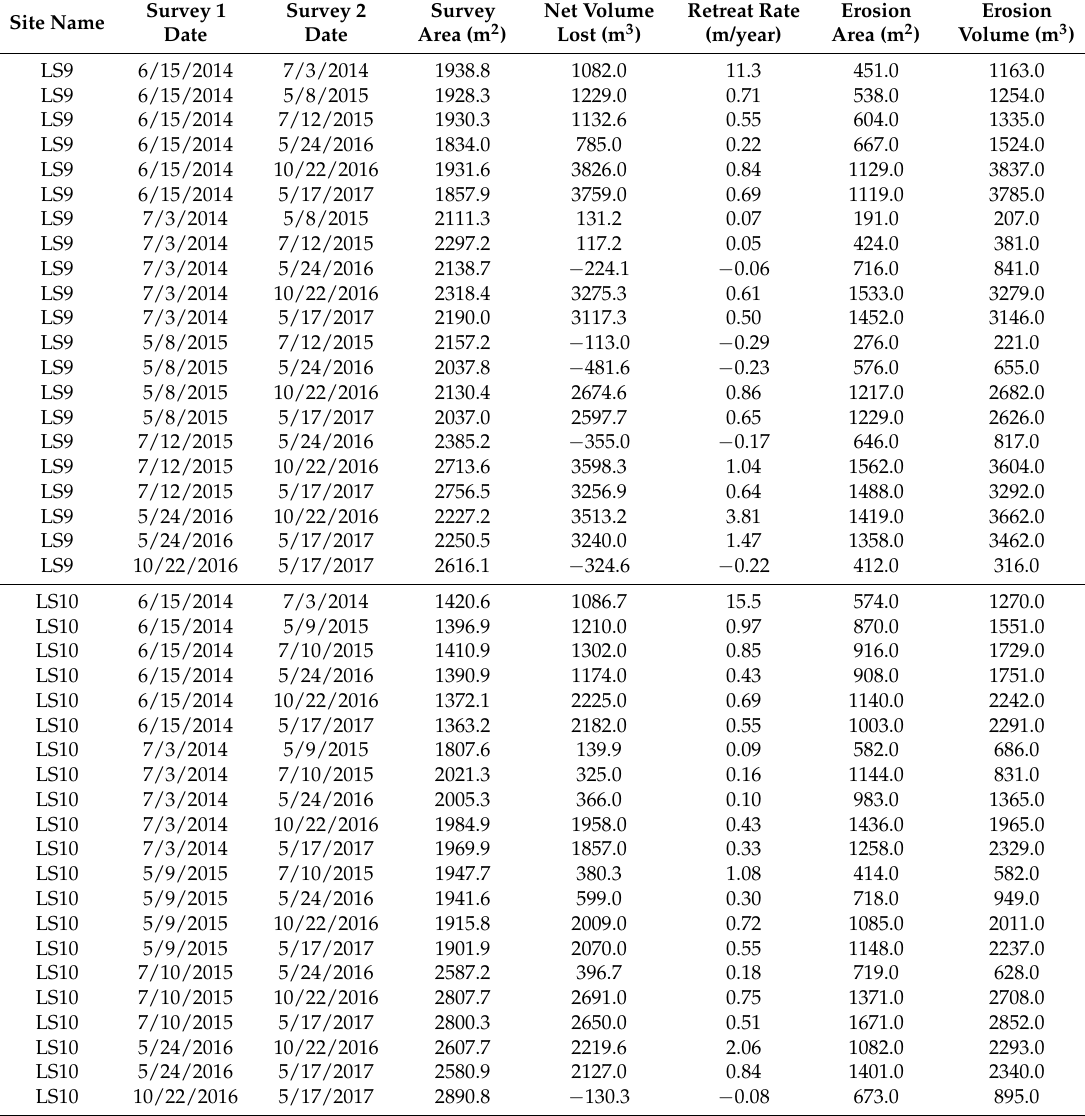
Table A2. Geomorphic change detection results from repeat SfM surveys at two bluffs sites on the Le Sueur River. Average annual retreat rates calculated as net volume lost (erosion positive) divided by entire survey area, divided by the amount of time, in years, between surveys. Right two columns report results for areas of erosion